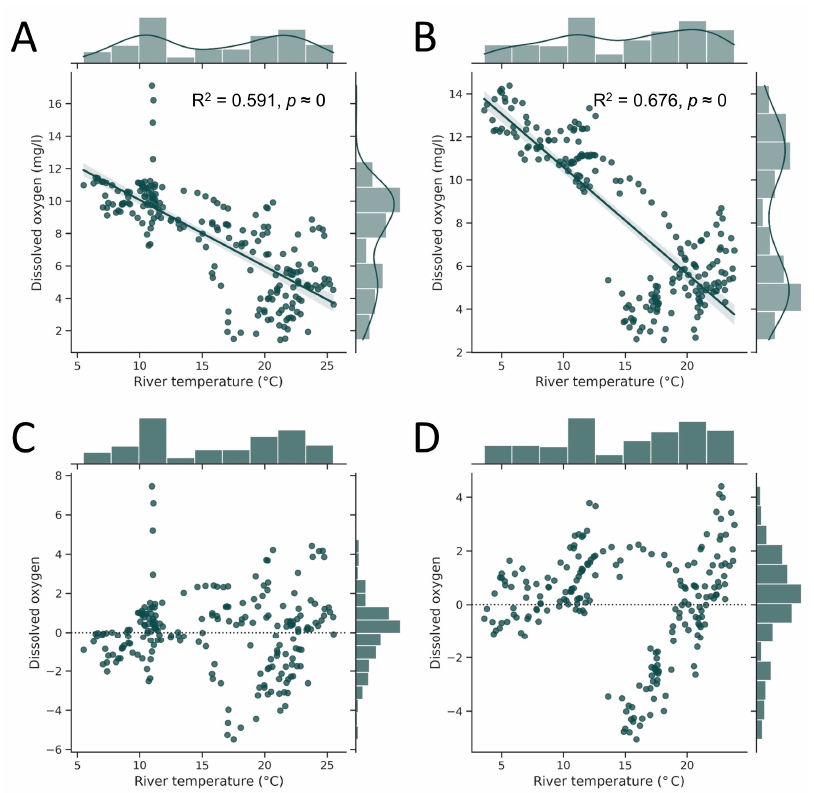
Figure 8. ( A , B ) Regression plot of temperature and DO of the Pivka River and ( C , D ) residual plot in 2017 and 2021, respectively.